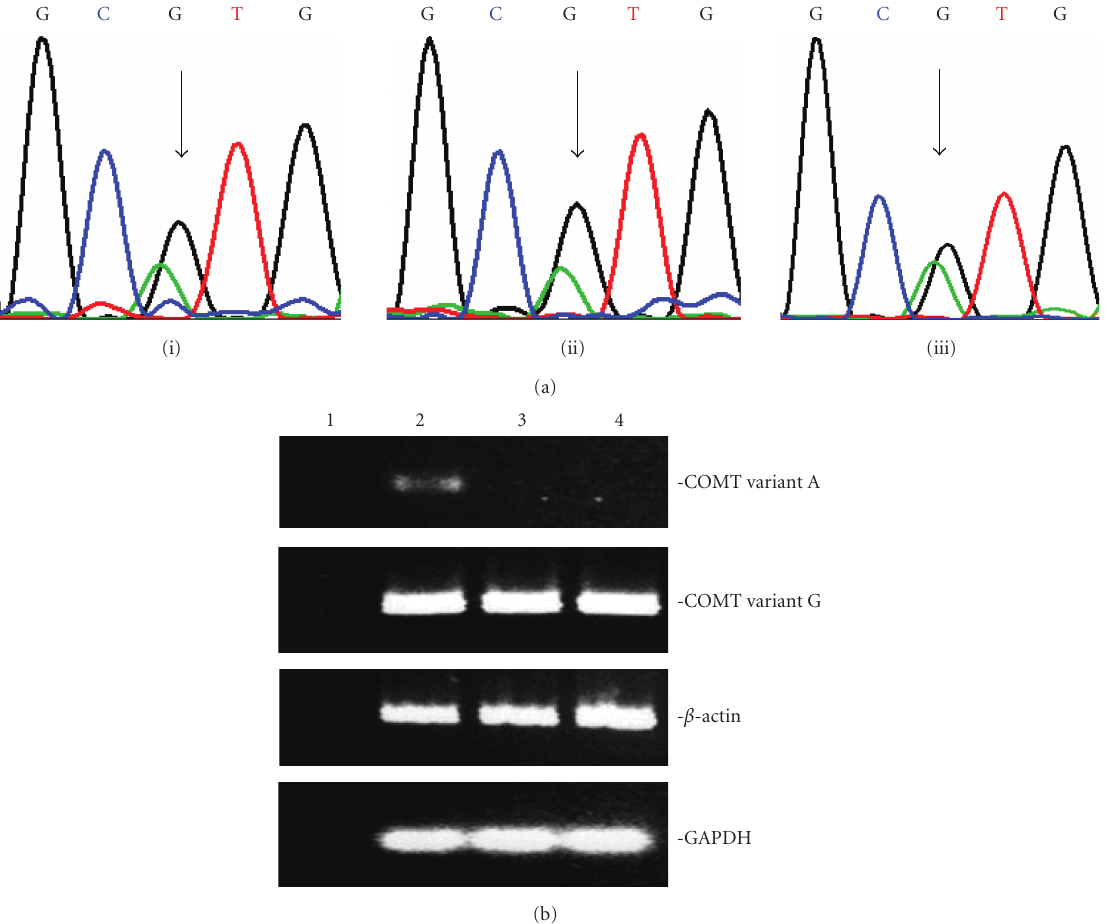
Figure 2: (a) Nucleotide sequence chromatograms across the COMT G675A haplotype using (i) patient DNA, (ii) patient cDNA, (iii) mRNA/cDNA from a normal control heterozygote. (b) Expression of the COMT G675A variants. COMT amplicons from semiquantitative RT-PCR were visualized on an agarose gel after 33 cycles using β 2 -actin and GAPDH (housekeeping genes) as the quantitation control. Lane 1—no cDNA control, lane 2—patient, lane 3 & 4—normal control individuals that were homozygous for the 675G